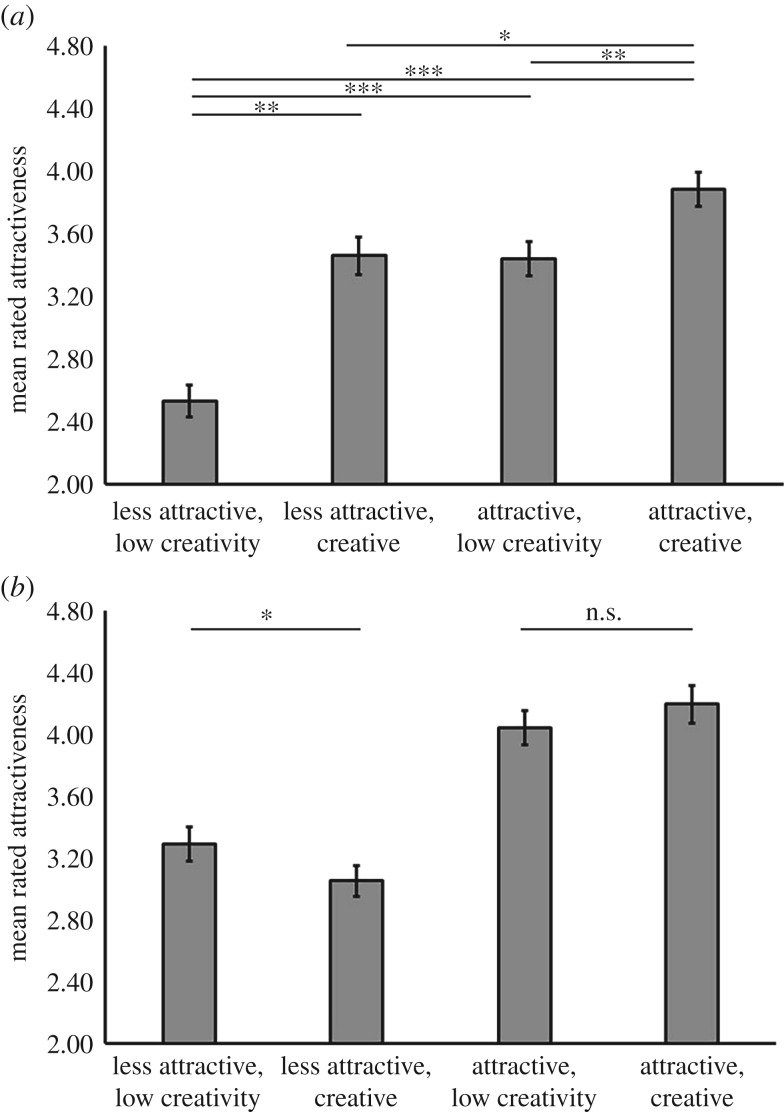
Replication of the significant interaction between face sex, creativity and facial attractiveness on overall attractiveness (ηp2 = 0.20). (a) Creativity has a more substantial effect on the attractiveness of men with average faces than it does for men with attractive faces (asterisks indicate * small, ** medium and *** large effect sizes). (b) Facial attractiveness has a more substantial effect on women's attractiveness than does their creativity. When comparing conditions (panel b only), all differences (four comparisons) represent a large effect size (Cohen's d) unless otherwise indicated (two comparisons).